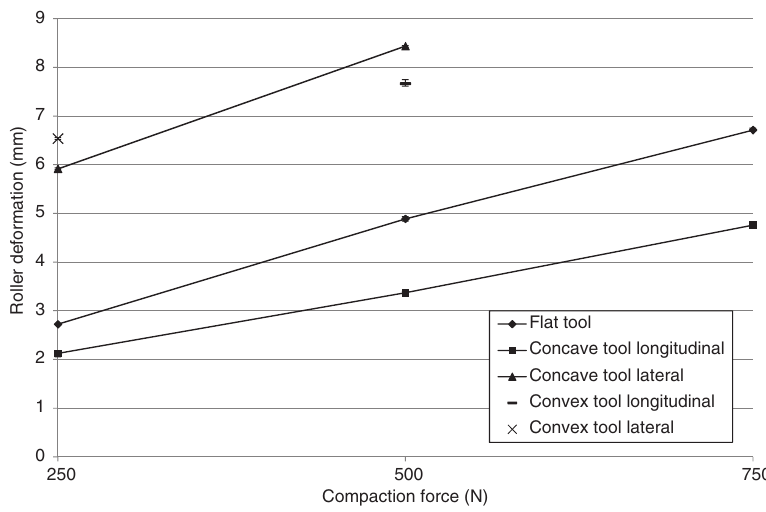
Figure 19 Displacement of the testing machine for all static roller tests.